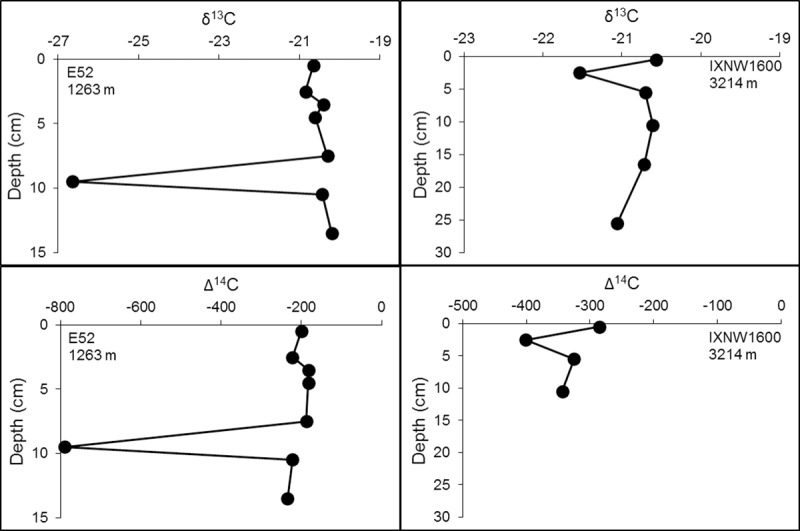
Isotopic (δ13C and Δ14C) profiles displaying depleted isotope values at a specific depth.Water depth at which the core was collected at is below core name on plots. The remaining core profiles can be seen in S1 Fig.